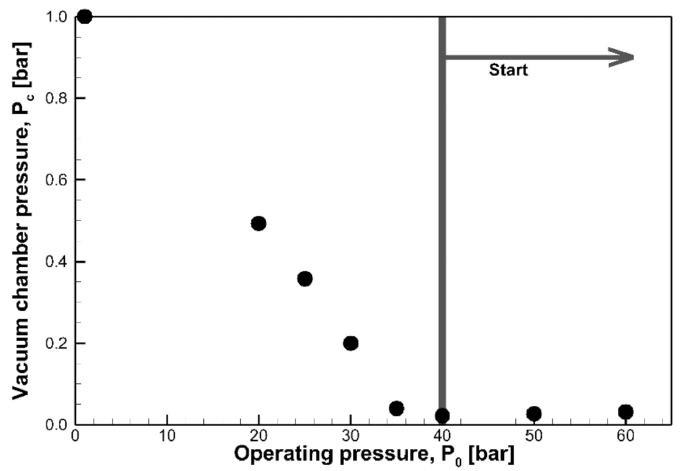
Figure 4. Vacuum chamber pressure of the baseline diffuser for various operating pressures.